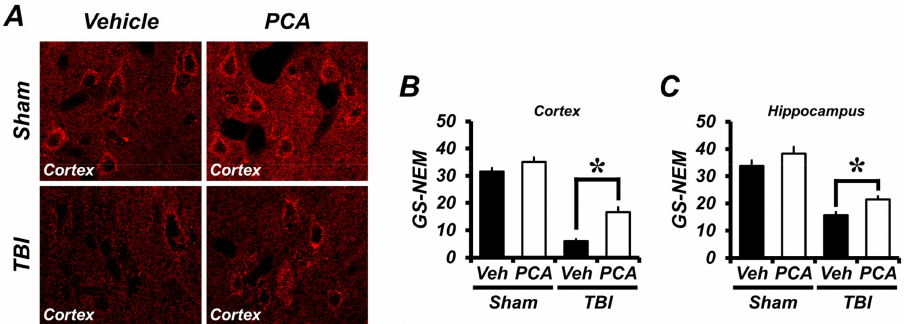
Figure 3. PCA reduces TBI-induced glutathione depletion in the hippocampus and cortex. ( A ) Fluorescence photomicrographs of brain sections stained with glutathione adduct with N -ethylmaleimide (GS-NEM) antibody. Sham-operated brain sections contain mostly GS-NEM in the hippocampal neurons and cortical neurons. Images show several GS-NEM negative neurons in the cortex area at one week after TBI. PCA administration increases the intensity of glutathione level in the hippocampus and cortex. Scale bar represents 20 µ m. ( B , C ) The bar graph shows the quantified GS-NEM fluorescence intensity in the cortex ( B ) and hippocampus ( C ). The GS-NEM fluorescence intensity was found to be significantly different between the vehicle and PCA treated group in the hippocampus and cortex area. Data are mean ± SEM, n = 5 from each sham group and n = 10 from each TBI group. * Significantly different from vehicle-treated group, p < 0.05.